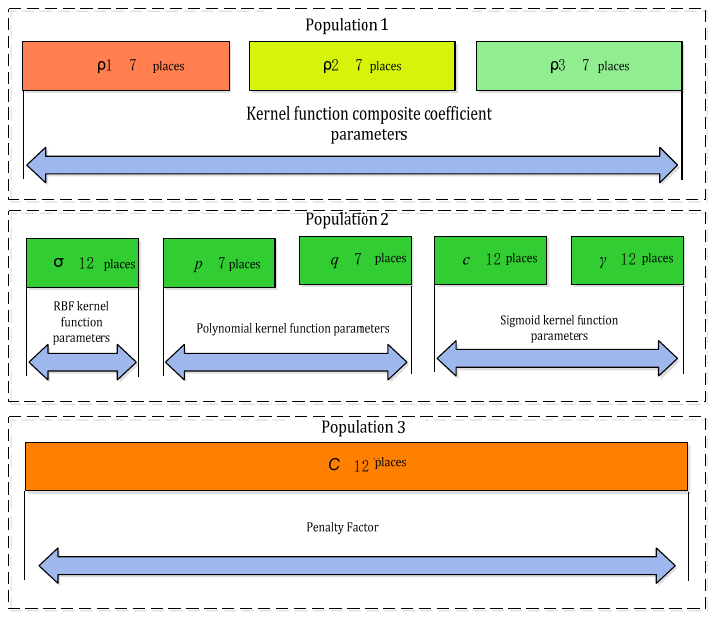
Figure 4. Chromosome coded bitmap.